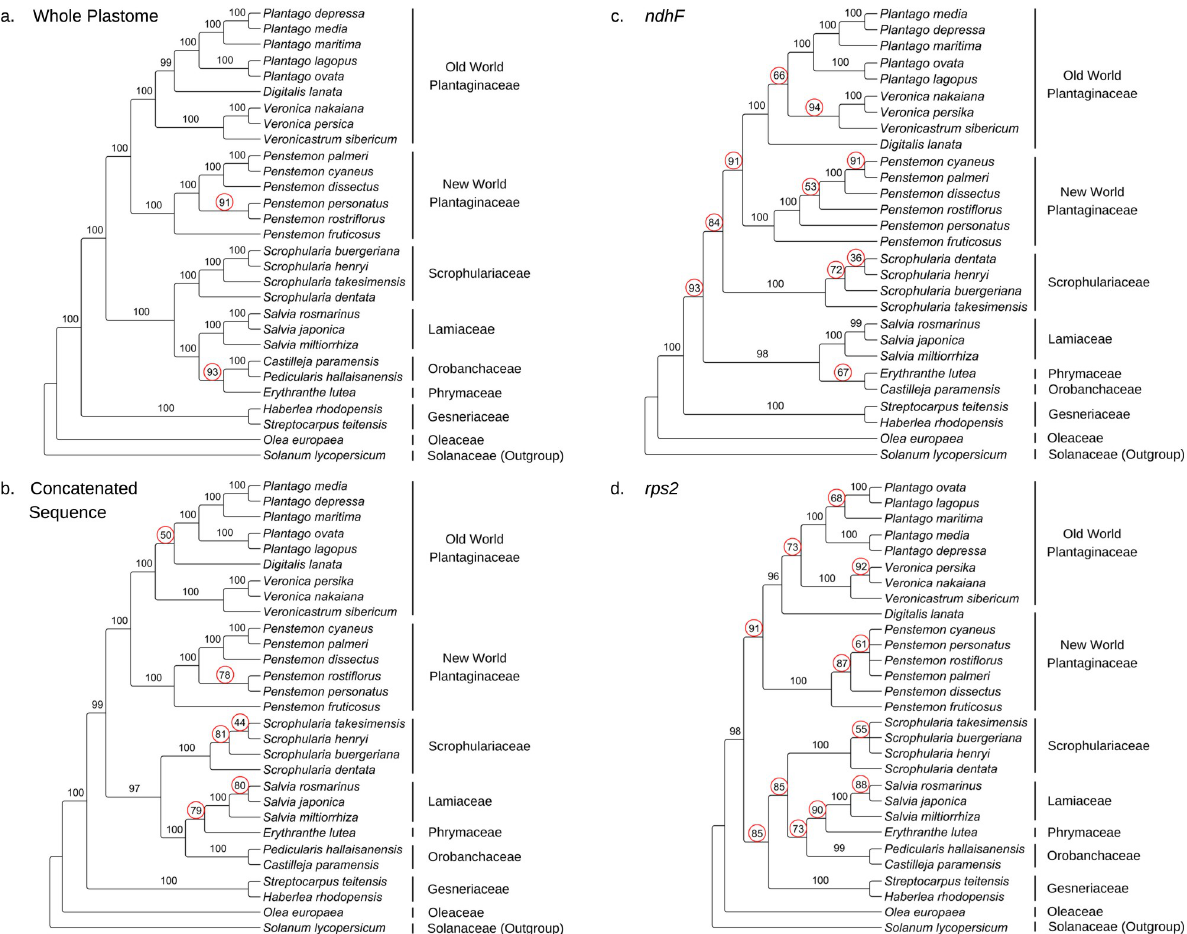
Fig 4. Maximum likelihood phylogenies of the Whole-plastome, concatenated sequence, ndhF , and rps2 sequences. A. The whole-plastome sequence phylogeny. B. The concatenated sequence ( matK , ndhF , psaA , psbA , rbcL , rpoC2 , and rps2 ) phylogeny. C. The ndhF sequence phylogeny. D. The rps2 sequence phylogeny. Bootstrap support values below 95 are emphasized with red circles.